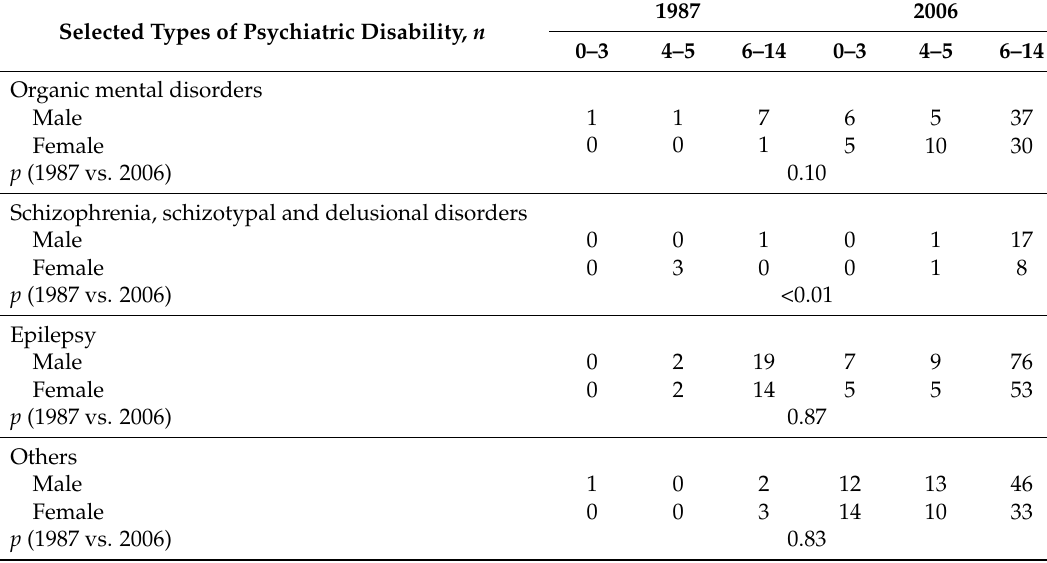
Table 4. Distribution of four most cases of psychiatric disability types in Chinese children psychiatric disability population by age groups